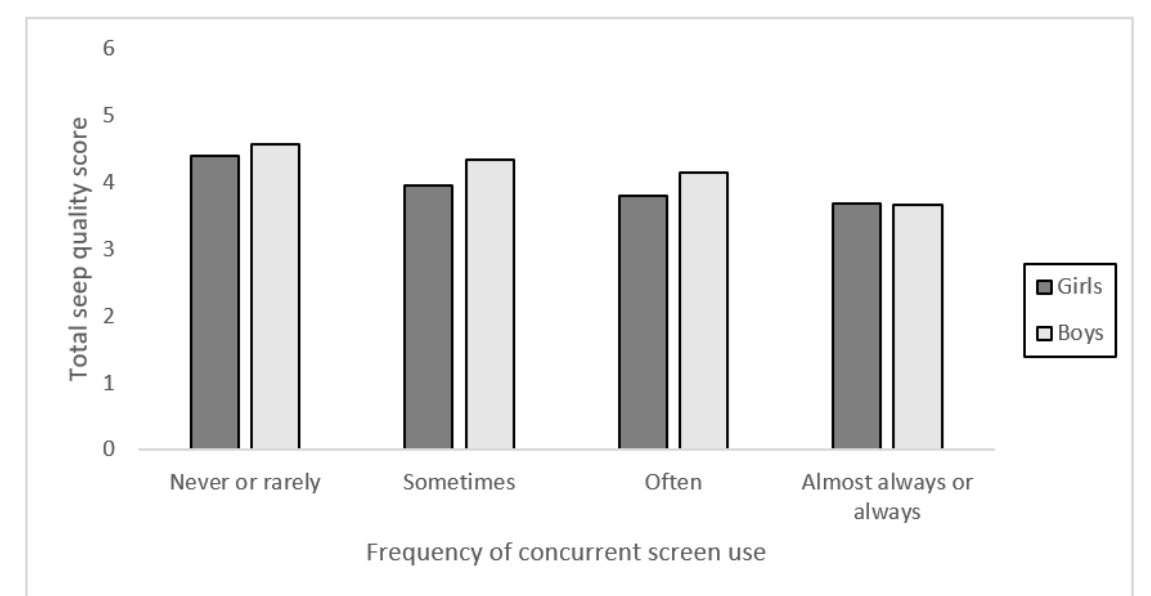
Figure 1. Association between frequency of concurrent screen use and sleep quality in adolescent girls and boys.